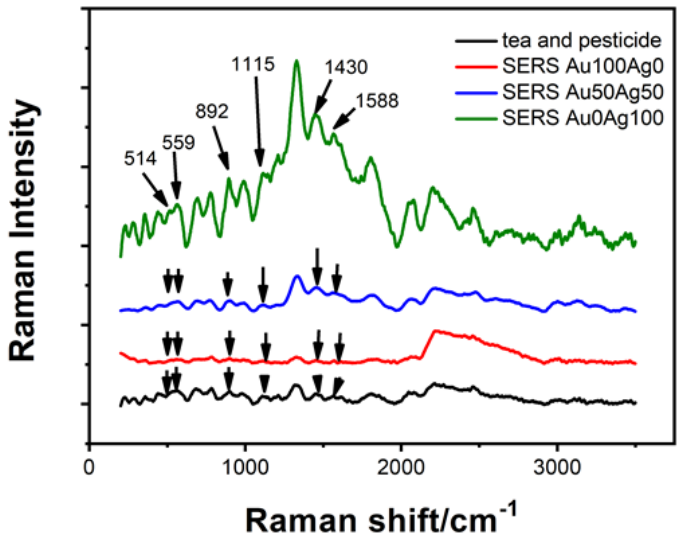
Figure 8. SERS spectra of brewed tea containing pesticides using colloidal Au100Ag0, Au50Ag50 and Au0Ag100 nanoparticles, in comparison with those without nanoparticles.